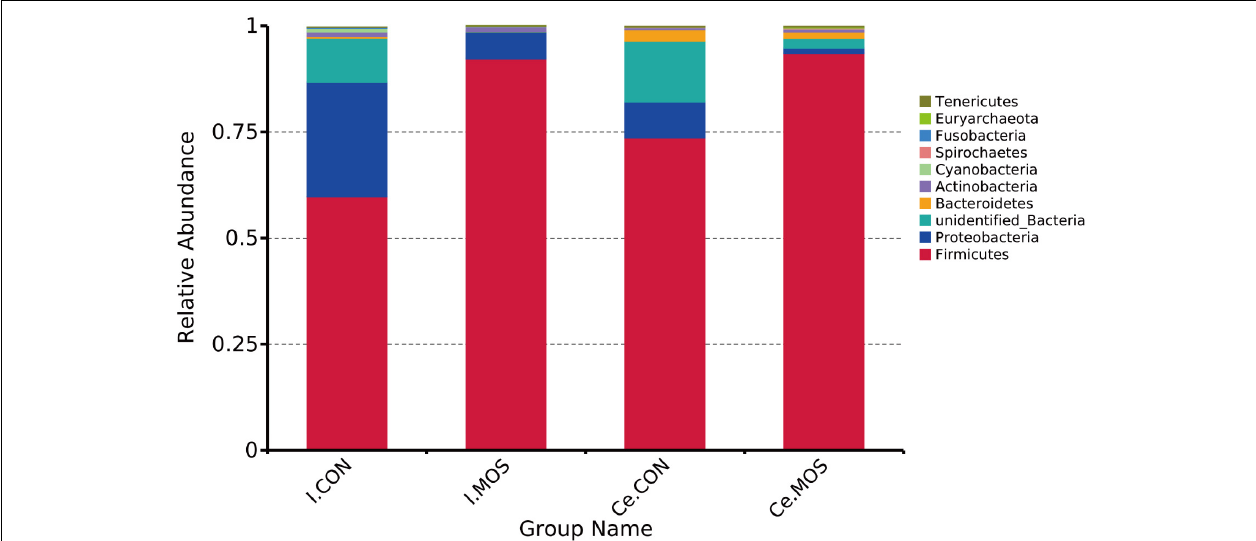
FIGURE 6 | Bar graph shows the phylum level composition of bacteria. Color-coded bar plot shows the relative abundance of bacterial phyla across the different groups. I.MOS means ileal digesta samples from pigs fed with a basal diet supplemented with 3 g/kg MOS; Ce.CON means cecal digesta samples from pigs fed